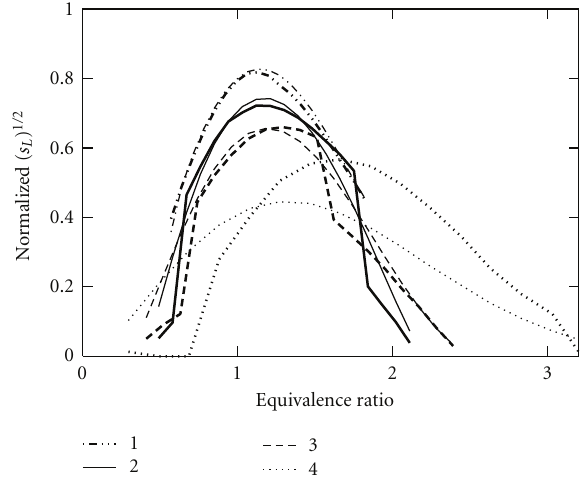
Figure 16: Dependencies of the square root s 1 / 2 mean laminar flame speed on the mean equivalence ratio F , calculated invoking the beta-function (thin curves) and the R-2 δ (bold curves) PDFs. g = 0 . 2. (1) F min = 0 . 5 and F max = 1 . 9, (2) F min = 0 . 4 and F max = 2 . 2, (3) F min = 0 . 3 and F max = 2 . 5, (4) F min = 0 . 1 and F max = 4 . 0.